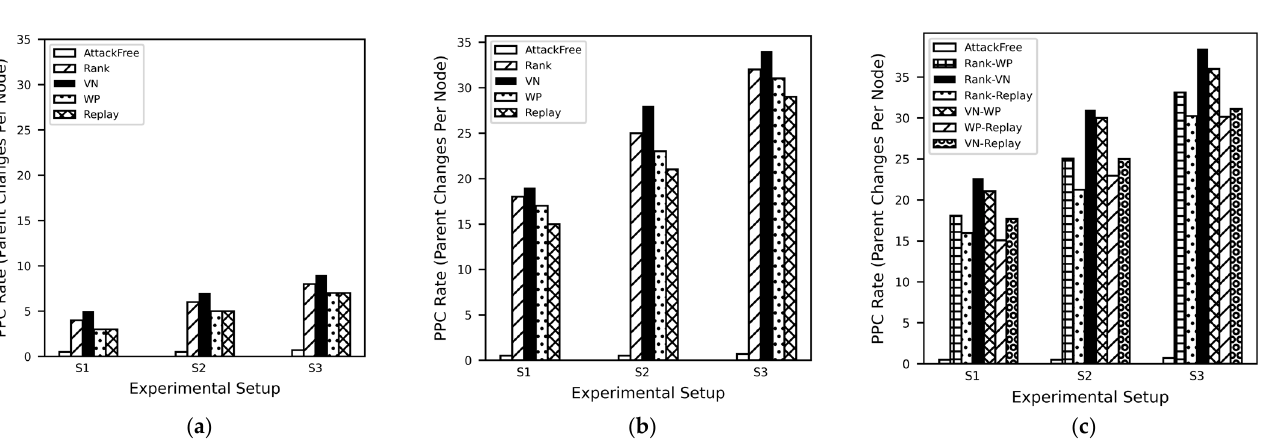
Figure 4. PPC Rate Results: ( a ) Single-Attack Scenario; ( b ) Composite-Attack Scenario; ( c ) Hybrid- Attack Scenario.